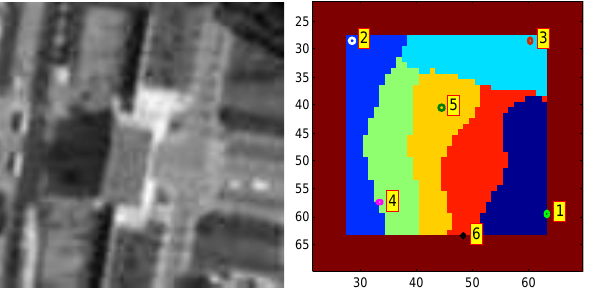
Figure 2. Template (left) and the centers of the selected subtemplates